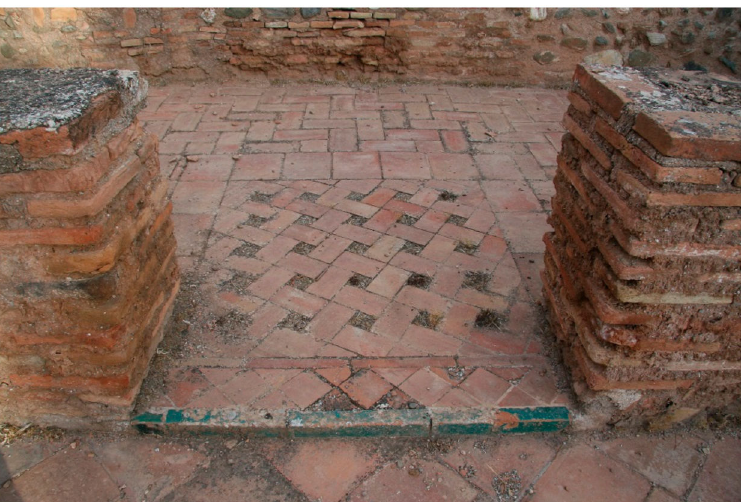
Figure 6. Reconstructed almatraya from the Nasrid period with missing glazed ceramic pieces from one of the houses alongside the Gate of the Seven Floors (Puerta de los Siete Suelos). © Mar í a Elena D í ez Jorge,